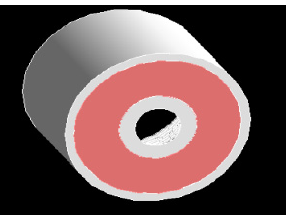
Figure 8. External structure of the proton probe.